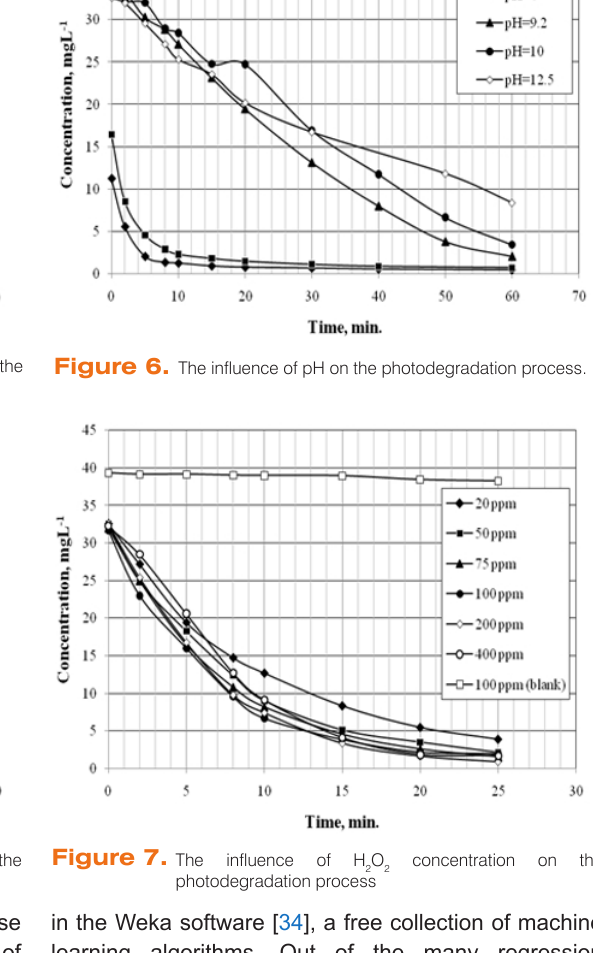
Figure 5. The influence of TiO photodegradation process